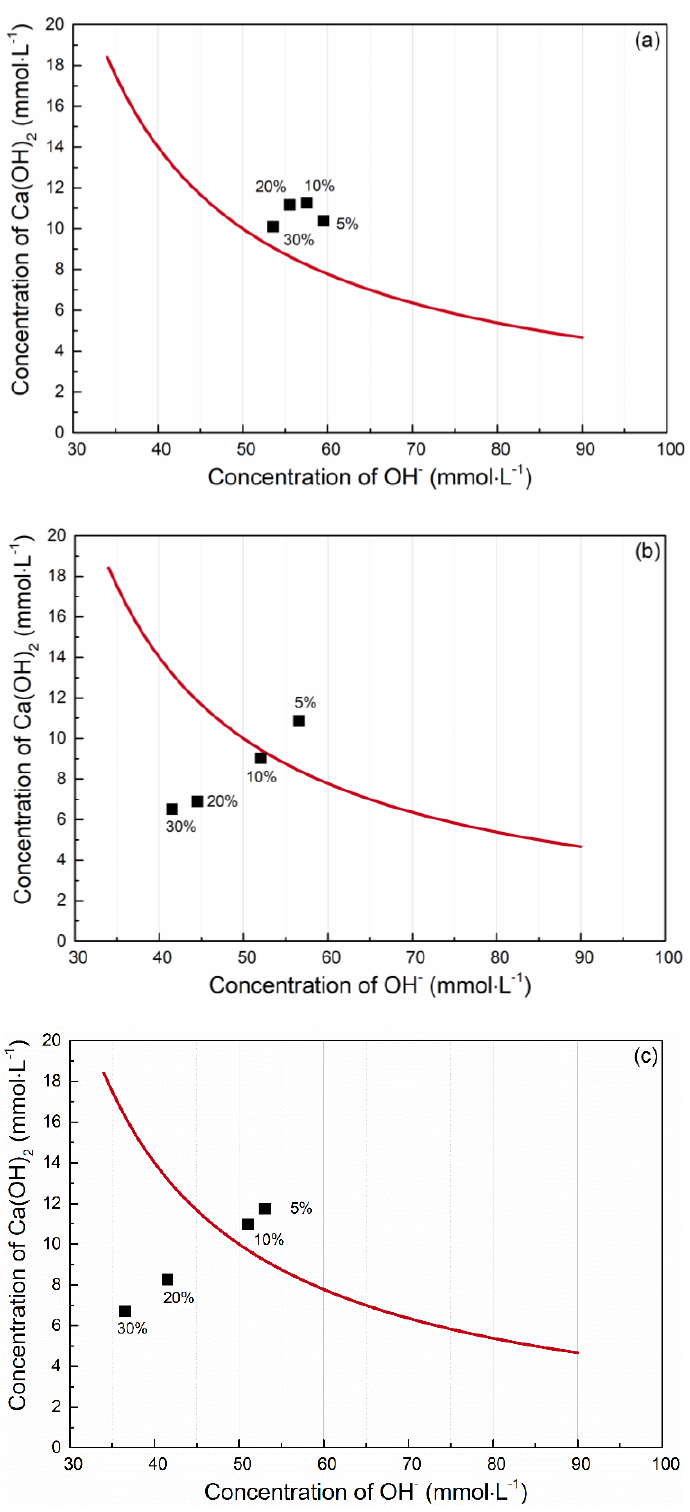
Figure 4. The pozzolana activity analysis of Diatomaceous earth using Frattini test, ( a ) ENO3, ( b ) ENO7, ( c ) BOR.